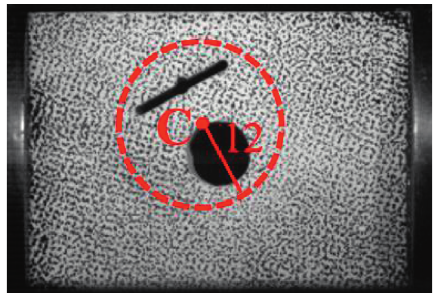
Figure 9: Diagrammatic sketch of the selected failure zone in specimen U-45.